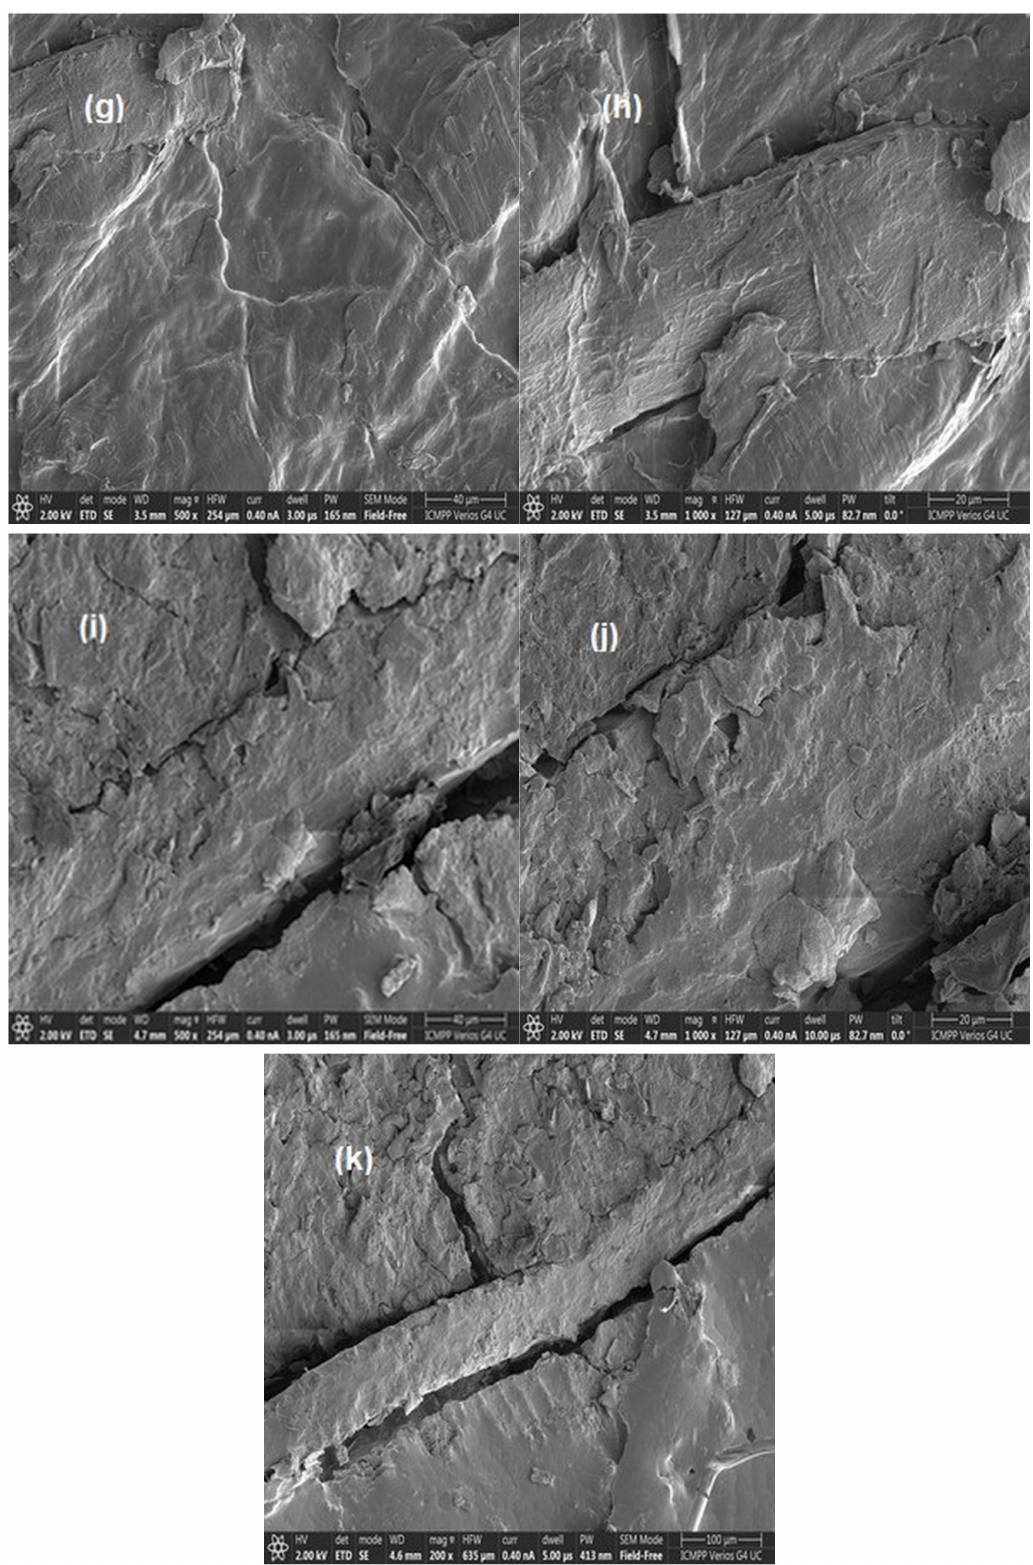
Figure 4. SEM images of ( a , b ) coir fibres; ( c , d ) polypropylene; ( e , f ) 25Co75PP; ( g , h )